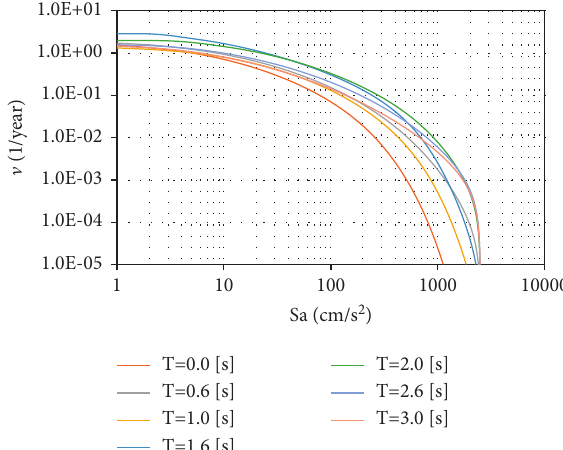
Figure 8: Seismic hazard curves.